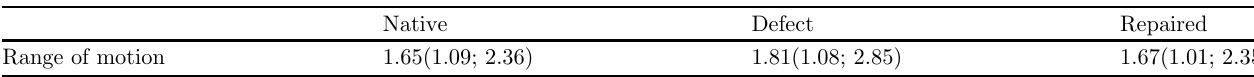
Table 3. Mean values with con fi dence intervals (cid:1) Rotation. Native Defect Repaired Range of